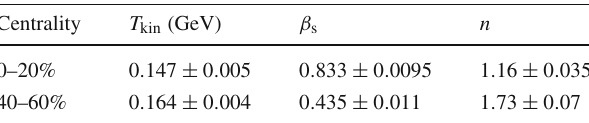
, p(p) and (cid:3) ( (cid:3) S